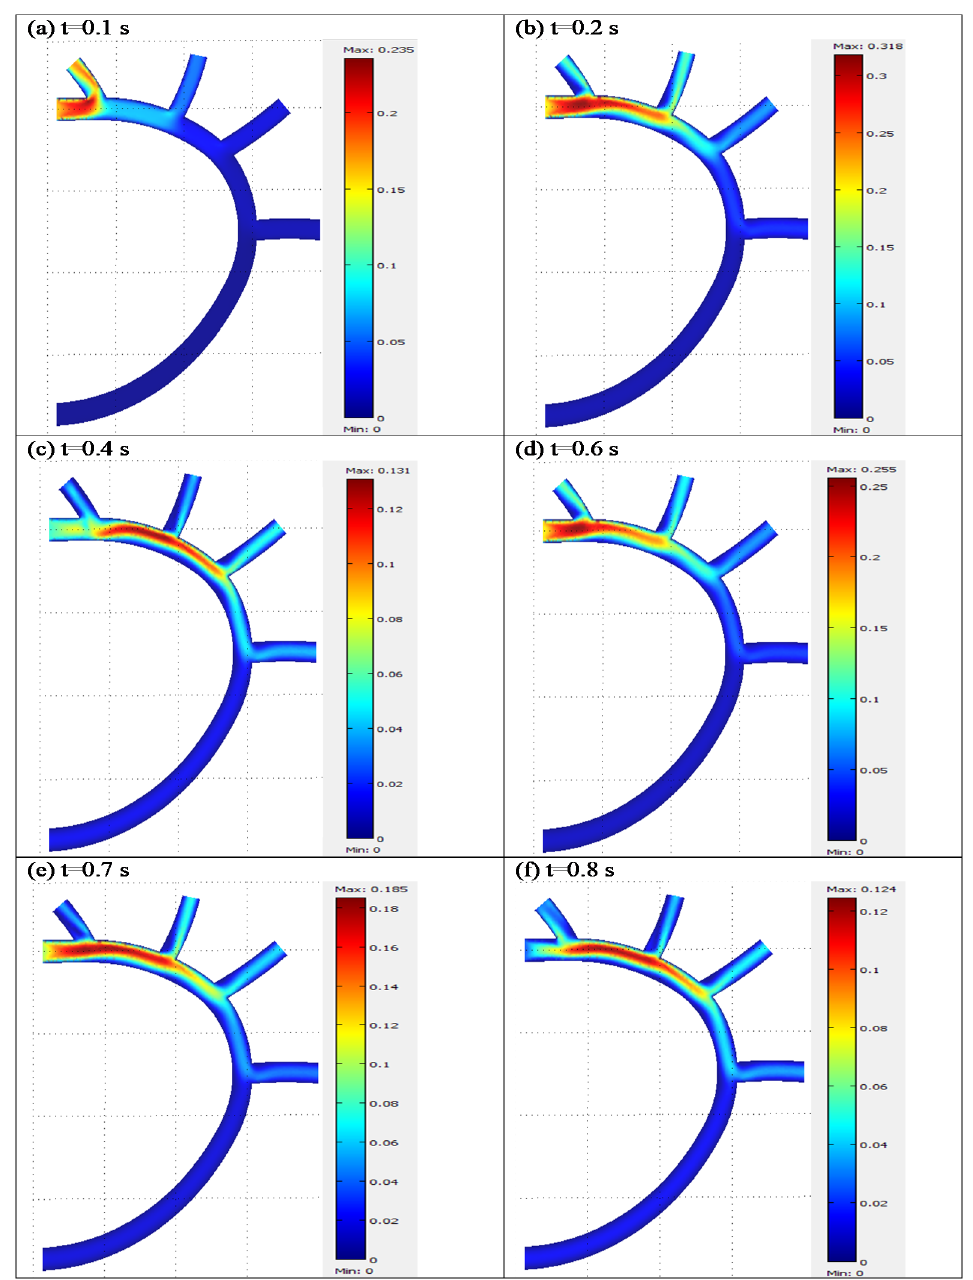
Figure 4. Blood velocity field distribution inside the vessel at different times; ( a ) t=0.1 s ( b ) t=0.2 s ( c ) t=0.4 s ( d ) t=0.6 s ( e ) t=0.7 s and ( f ) t=0.8 s.